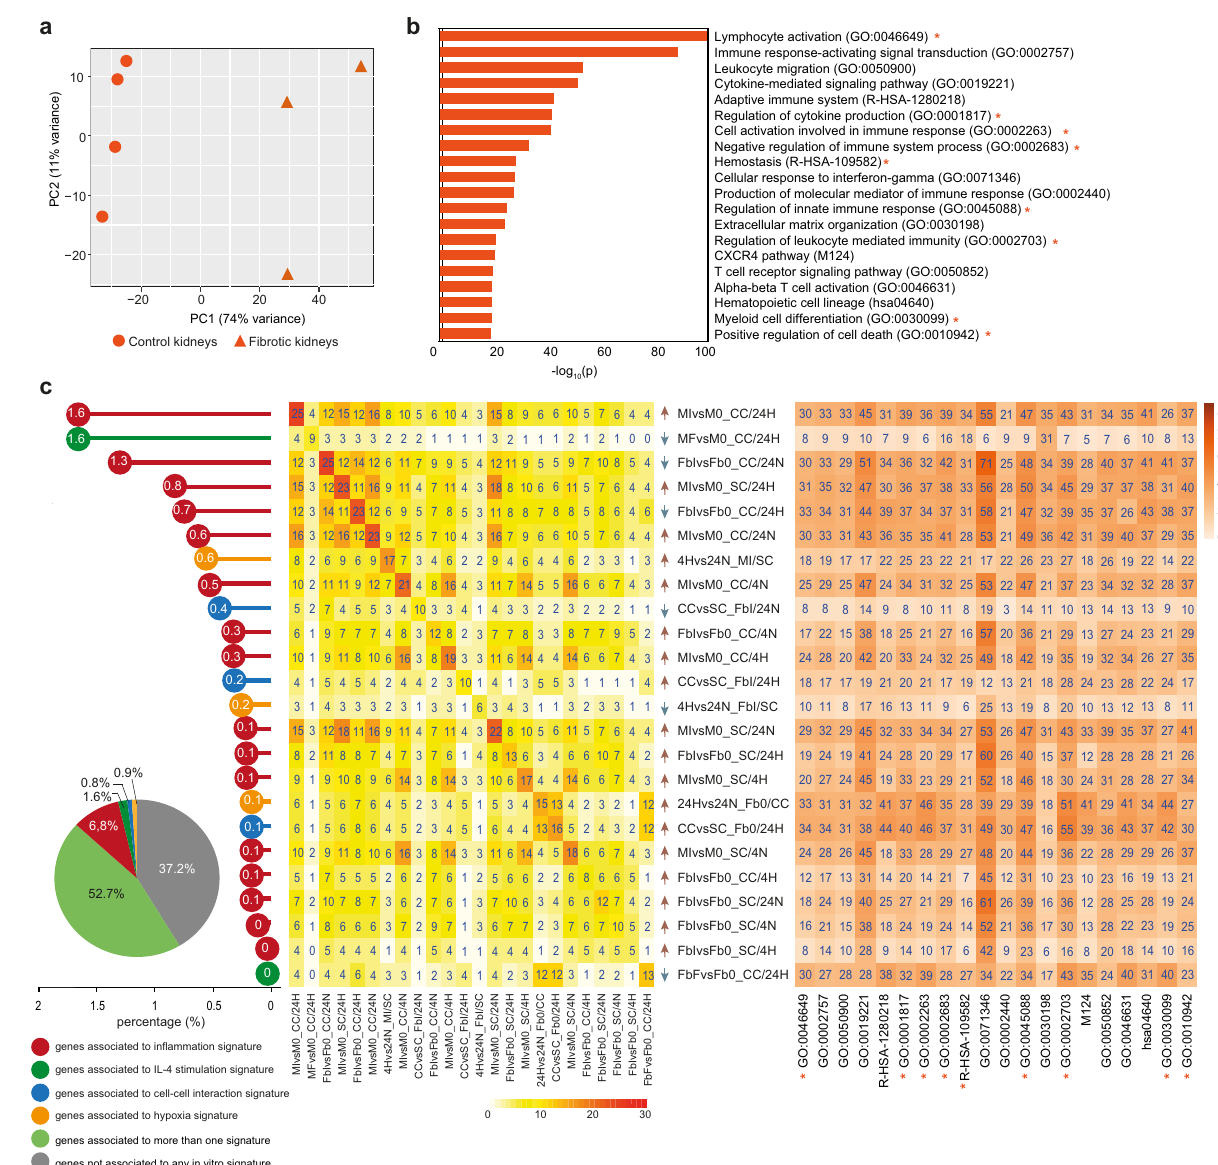
Fig. 8 | Gene overlap analysis of ex vivo glomeruli surrounding area from fi brotic kidneys within vitro signatures.a PCA ofex vivoglomerulisurrounding areasamples.Trianglesindicate fi brotickidneys,dotscontrolsamples. b